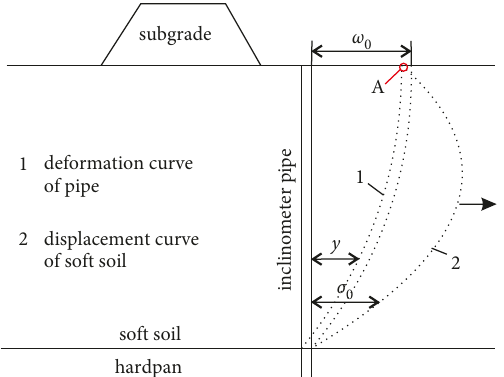
Figure 3: Schematic of the deformations of the inclinometer pipe and soft soil.